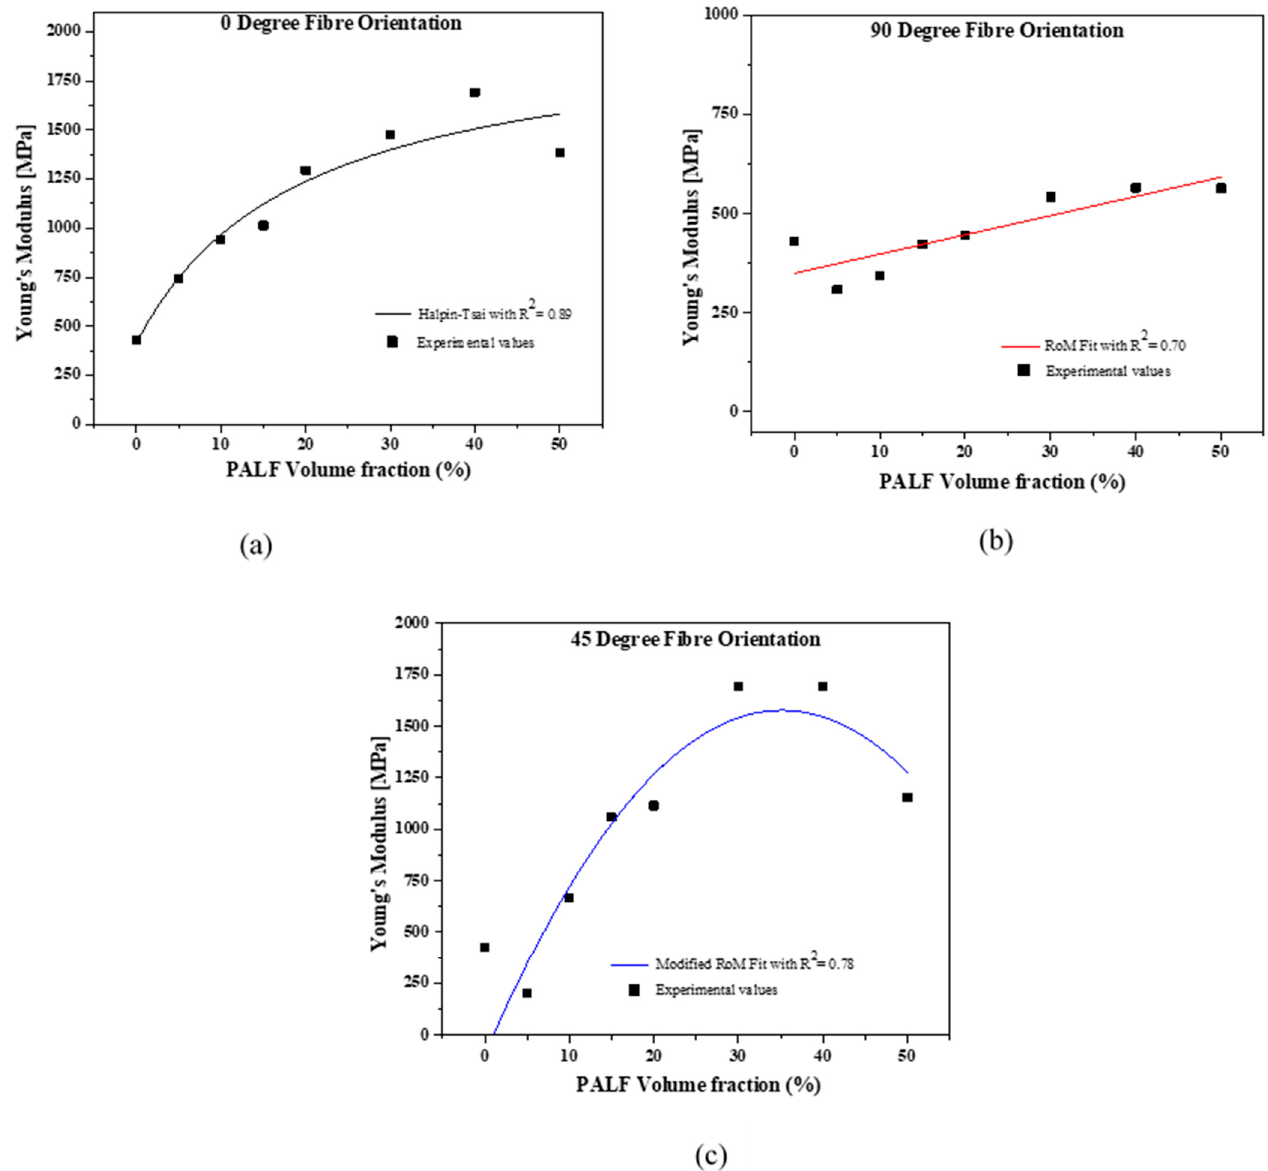
Figure 3. Experimental Young’s moduli of cured PALF/MMA composites fitted by ( a ) Halpin–Tsai, ( b ) Modified Rule of Mixture and ( c ) Rule of mixture as a function of fiber volume fraction oriented at 0, 45 and 90°, respectively.